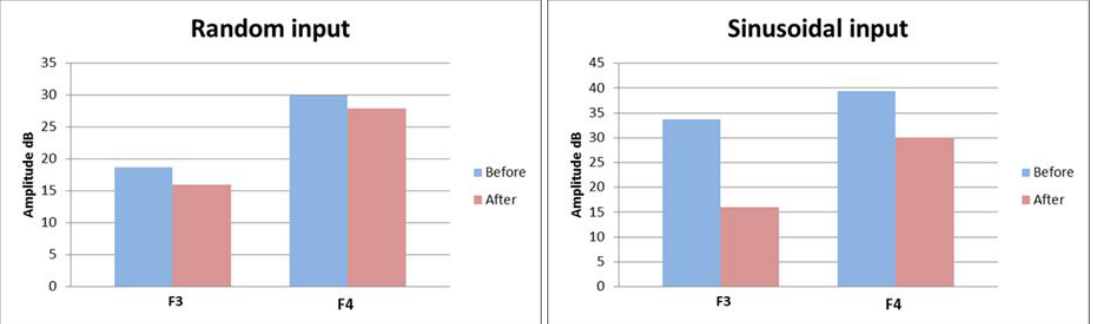
Fig. 7. Figure shows event related spectral power for theta band in random and sinusoidal vibration. A decrease in beta wave during sinu- soidal vibration are more pronounced compared to random vibration.